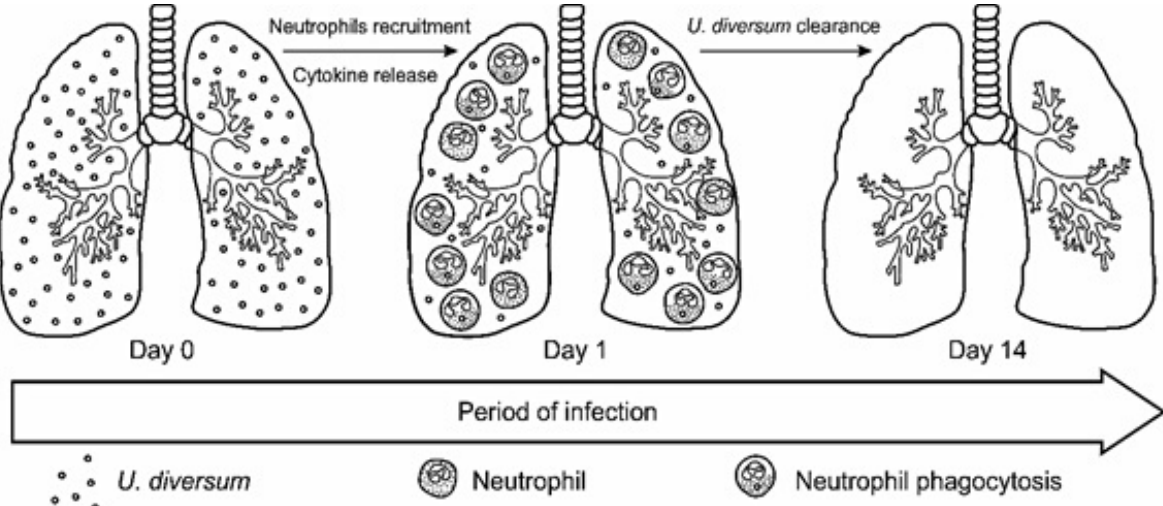
Figure 6. Schematic figure of U. diversum clearance. Mice were infected intratracheally by 10 4 CCU of U. diversum and euthanized 1, 2, 3, 7 and 14 days after infection. The results show that neutrophils are able to phagocyte U. diversum , performing the depuration of the microorganism and the role of neutrophils involves phagocytosis, in addition to the production of cytokines, capable of activating other cells involved in the elimination of the